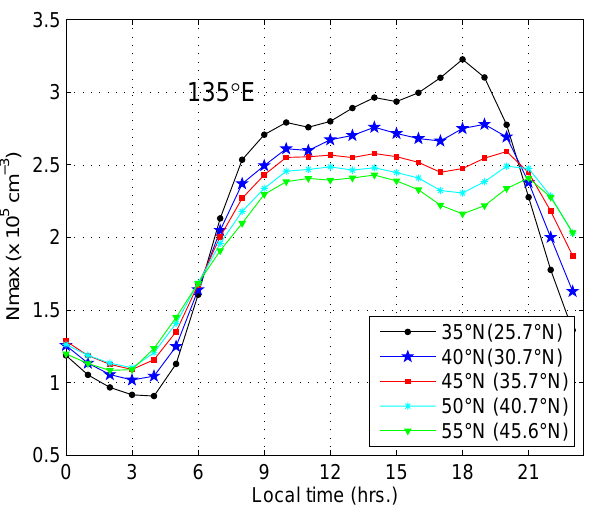
Fig. 2. Local time variation of electron densotity at various al- titudes, at (45 ◦ N, 135 ◦ E) during July 2008, obtained from F3/C